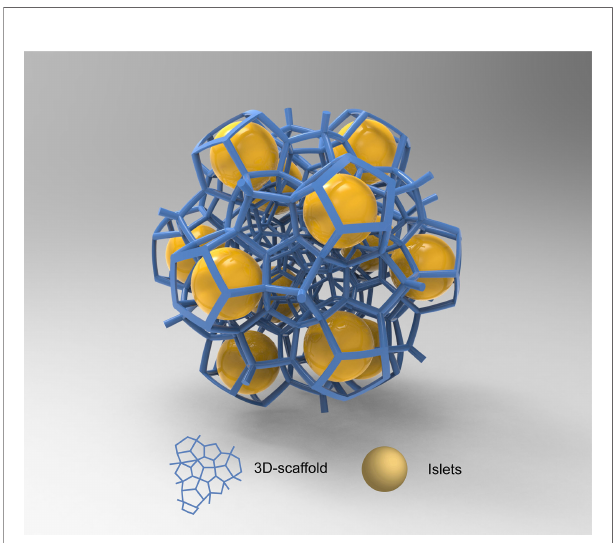
FIGURE 4 | 3D-capsule schematic diagram. Special biomaterials are used as inks to print 3d scaffolds in which cells are housed. The yellow spheres in the fi gure are islet cells, and the blue scaffold is 3D